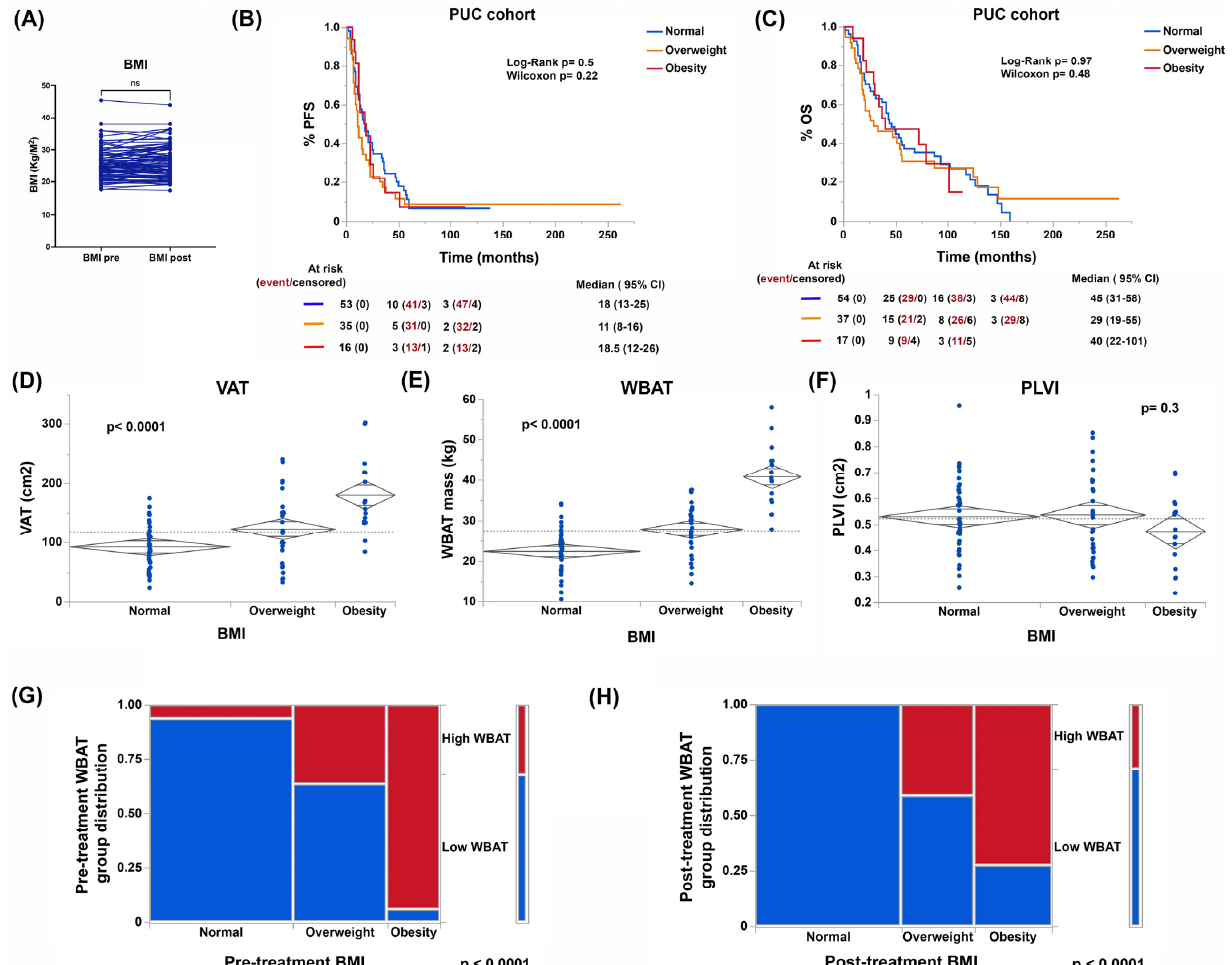
Figure 1. BMI trends ( A ), its impact on progression-free (PFS, B ) and overall survival (OS, C ), and its correlation with adiposity (visceral adiposity [VAT], whole body adipose tissue [WBAT]) and muscle mass (psoas to lumbar vertebrae index [PLVI]) ( D – F ) pre- and post- completion of planned treatment ( G , H ) in the PUC cohort. NS stands for non-significant.